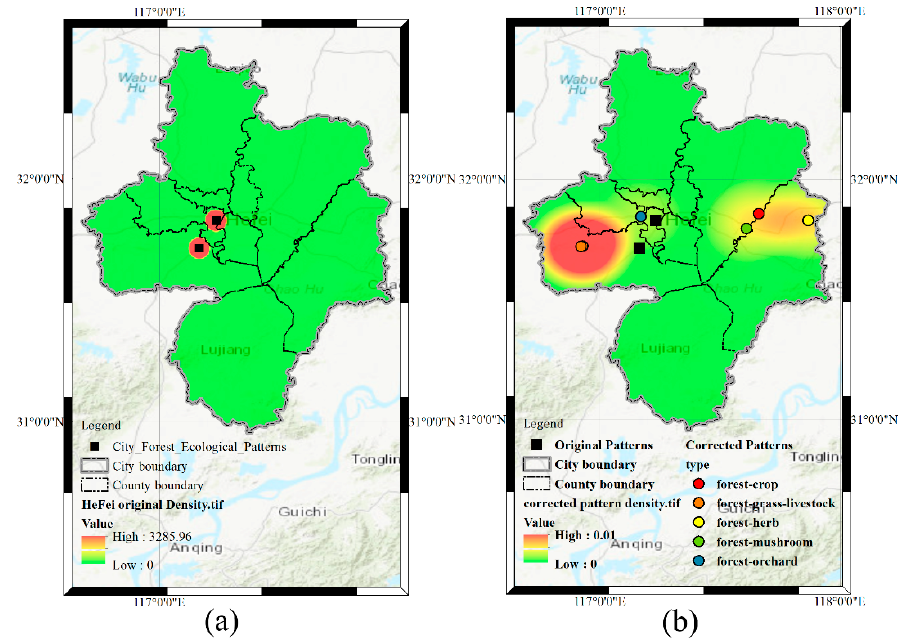
Figure 8. Density maps of Hefei forest ecological patterns. ( a) Pre-correction density pattern. ( b ) Post-correction density pattern.